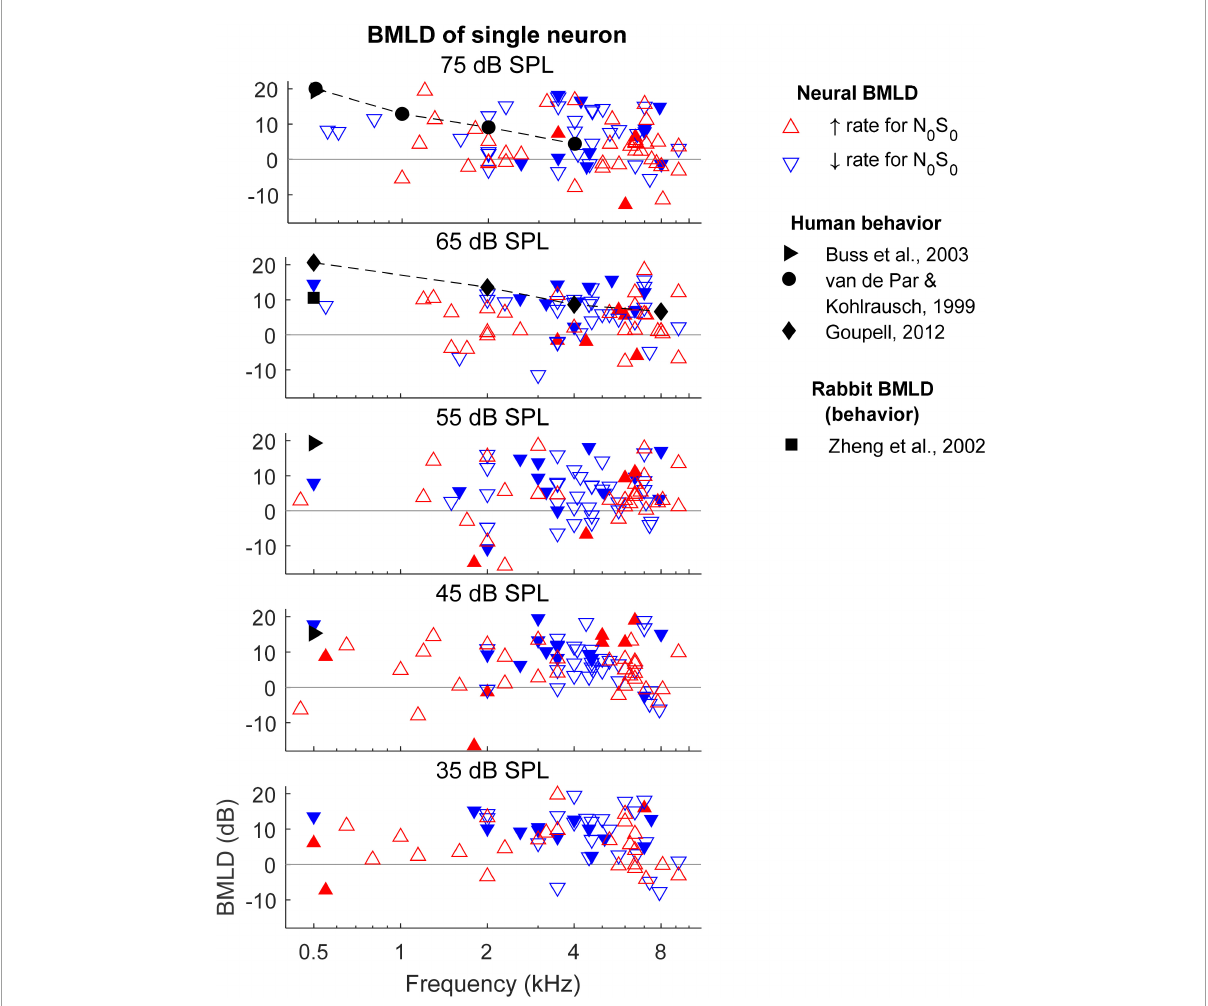
FIGURE8 Binaural masking level differences (BMLDs) calculated based on single-neuron thresholds for both N 0 S 0 and N 0 S π conditions. Open triangles indicate that the direction of change in rate vs. SNR at threshold for the N 0 S π condition was the same as for the N 0 S 0 condition, whereas filled triangles indicate opposite direction of change in rate at threshold for the N 0 S 0 and N 0 S π conditions. Only neurons that had measurable thresholds in both N 0 S 0 and N 0 S π conditions are shown